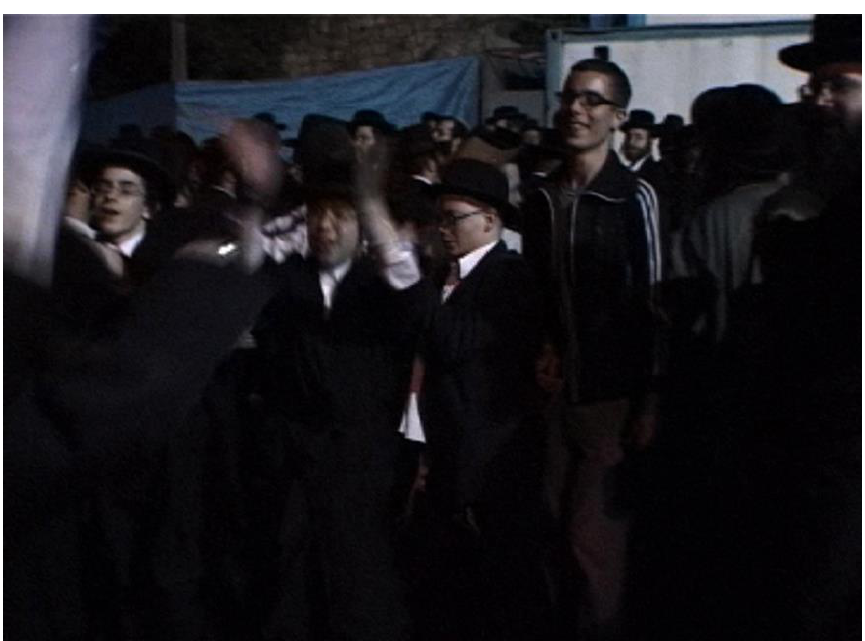
Figure 11. Oreet Ashery, Dancing with Men , 2003, 05:26. Video still, 04:09 min.